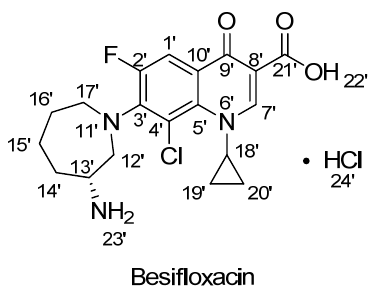
Figure 1. The structure of